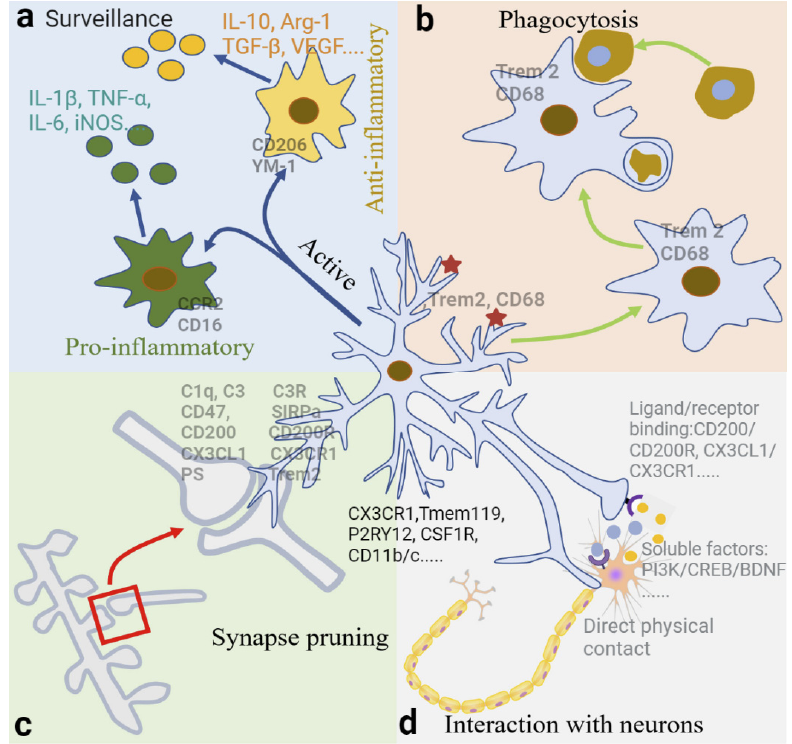
Figure 2. Physiological function of microglia. ( a ) Microglia constantly monitor neuronal health and function status through their necessary branches. Microglia change their morphology in response to alterations in the surrounding microenvironment. Activated microglia can exert pro-inflammatory or anti-inflammatory roles by secreting cytokines. The surface markers and the products secreted by each phenotype are shown in the figure. ( b ) Microglia protect the brain and maintain microenvironment homeostasis by removing harmful factors through phagocytosis. ( c ) Microglia execute synaptic pruning. Signaling involved in microglia-mediated synaptic pruning is listed in the figure. ( d ) Microglia interact with neurons directly or indirectly, via direct physical contact, ligand/receptor binding and signaling, and soluble factors released by microglia and neurons. Abbreviations: IL-1 β , interleukin-1 β ; IL-6, interleukin-6; IL-10, interleukin-10; TNF- α , tumor necrosis factor α ; iNOS, inducible nitric oxide synthase; Arg-1, arginase 1; TGF- β , transforming growth factor β ; VEGF, vascular endothelial growth factor; CCR2, C-C motif chemokine receptor 2; CD16, cluster of differentiation 16, the Fc receptors Fc γ RIIIa; CD206, cluster of differentiation 206, the mannose receptor; YM-1; chitinase-like protein 3, Chil3; Trem2, triggering receptor expressed on myeloid cells 2; CD68, cluster of differentiation 68; C1q and C3, the complement component 1q and 3; C3R, C3 receptor; CD47, cluster of differentiation 47; SIRPa, signal regulatory protein α ; CD200, cluster of differentiation 200; CD200R, CD200 receptor; CX3CL1, C-X3-C motif chemokine ligand 1; CX3CR1, C-X3-C motif chemokine receptor 1; PS, phosphatidylserine; Tmem119, transmembrane Protein 119; P2RY12, purinergic receptor P2Y12; CSF1R, colony-stimulating factor 1 receptor; CD11b/c, cluster of differentiation 11b/c; PI3K, phosphoinositide 3-kinases; CREB, cAMP response element binding protein; BDNF, brain-derived neurotrophic factor.